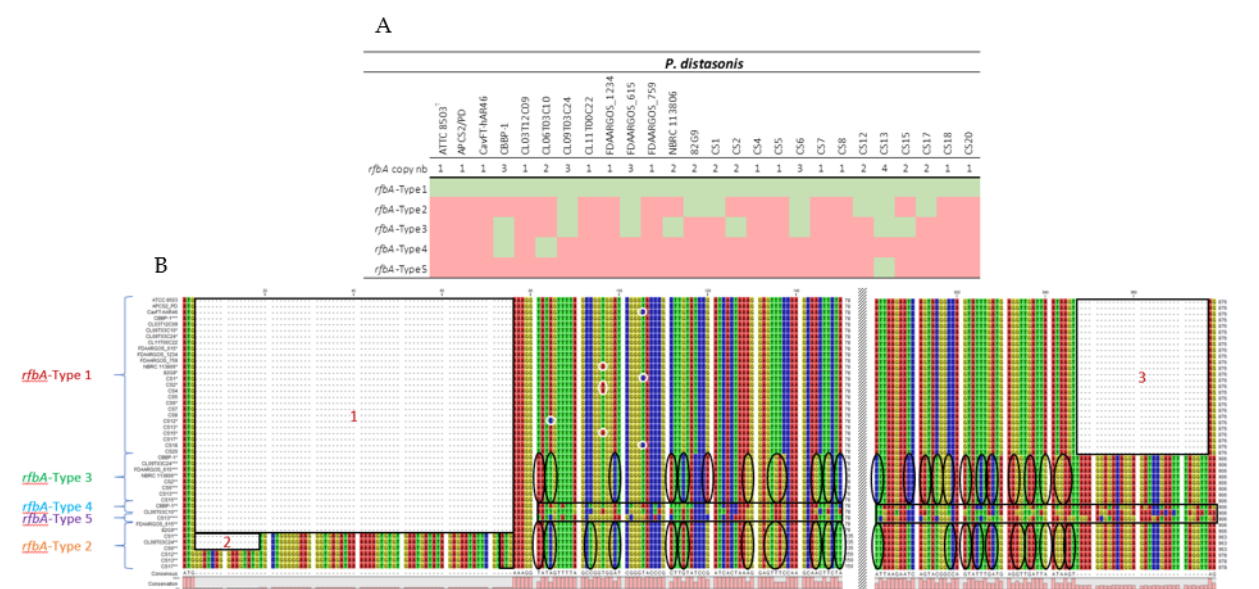
Figure 5. Classification and characterization of rfbA genes of P. distasonis . ( A ) rfbA copy number and classification of each P. distasonis strain. Color code: presence (green) or absence (red) of the rfbA gene of the indicated type. ( B ) rfbA -type nucleotide sequences and gaps analysis. Gaps are framed and numerated from 1 to 3. rfbA -type 1 single-nucleotide polymorphism are surrounded in white. Variation of rfbA -type 2 and 3 from rfbA -type 1 are highlighted by black circles. rfbA -type 4 and 5 are framed in black due to the important number of variations compared to the rfbA -type 1.